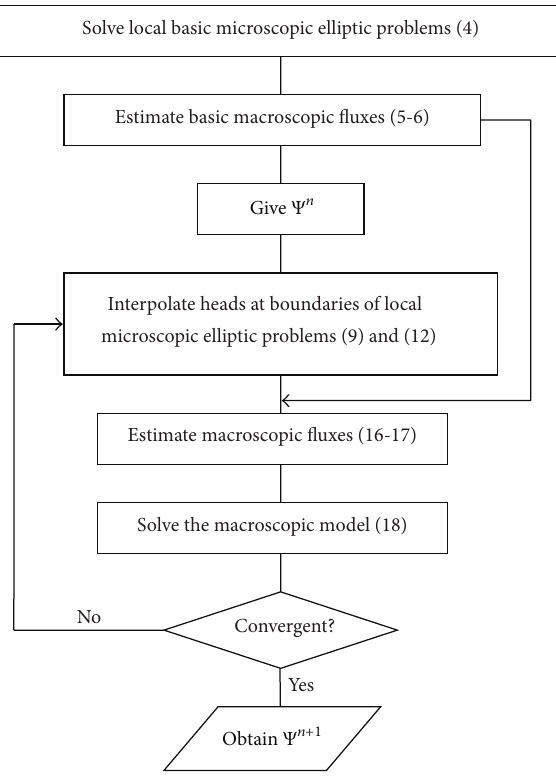
Figure 3: Flow chart of the new scheme at a time